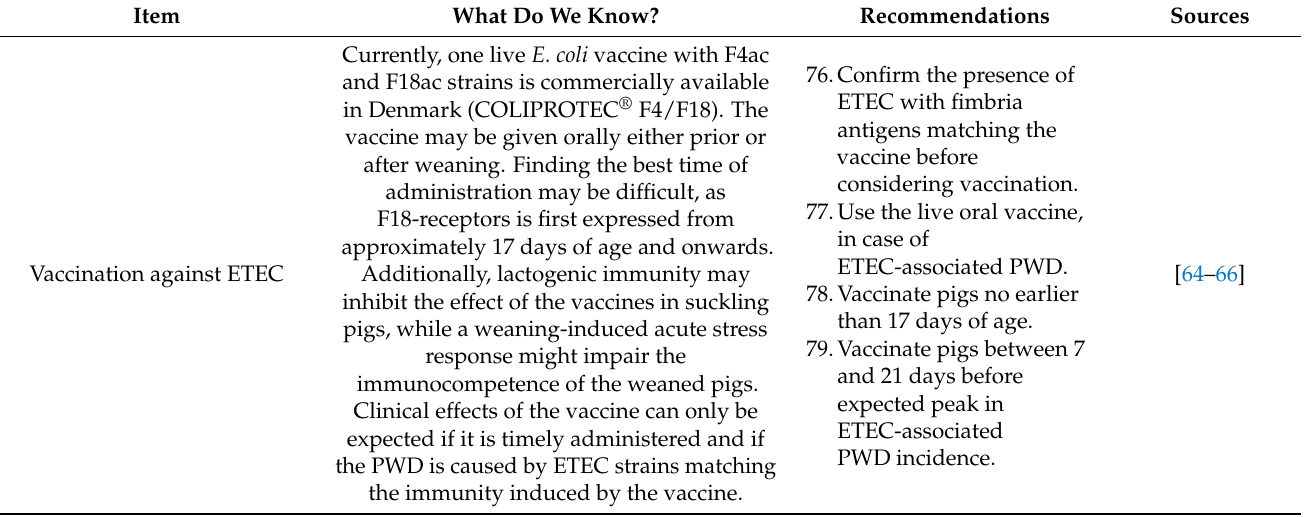
Table 7. Management of specific